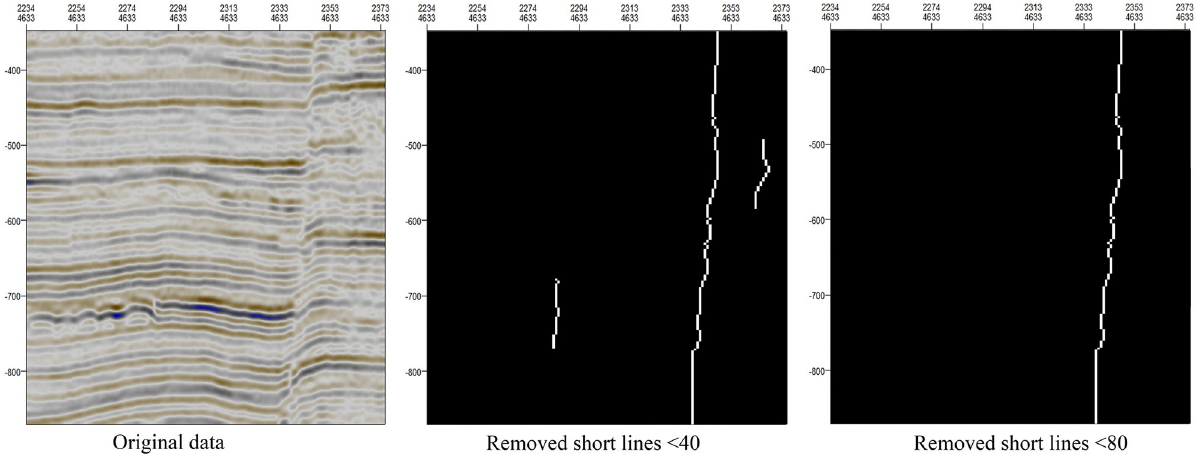
Fig 11. Influence of the removal of short lines of different lengths on the results of fault extraction.